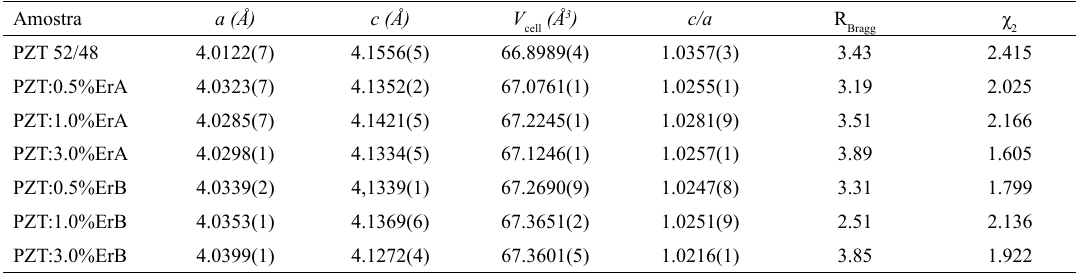
Table 2. Lattice parameters a, c , cell volume, tetragonality and statistical parameters of refinement Rietveld results. Amostra